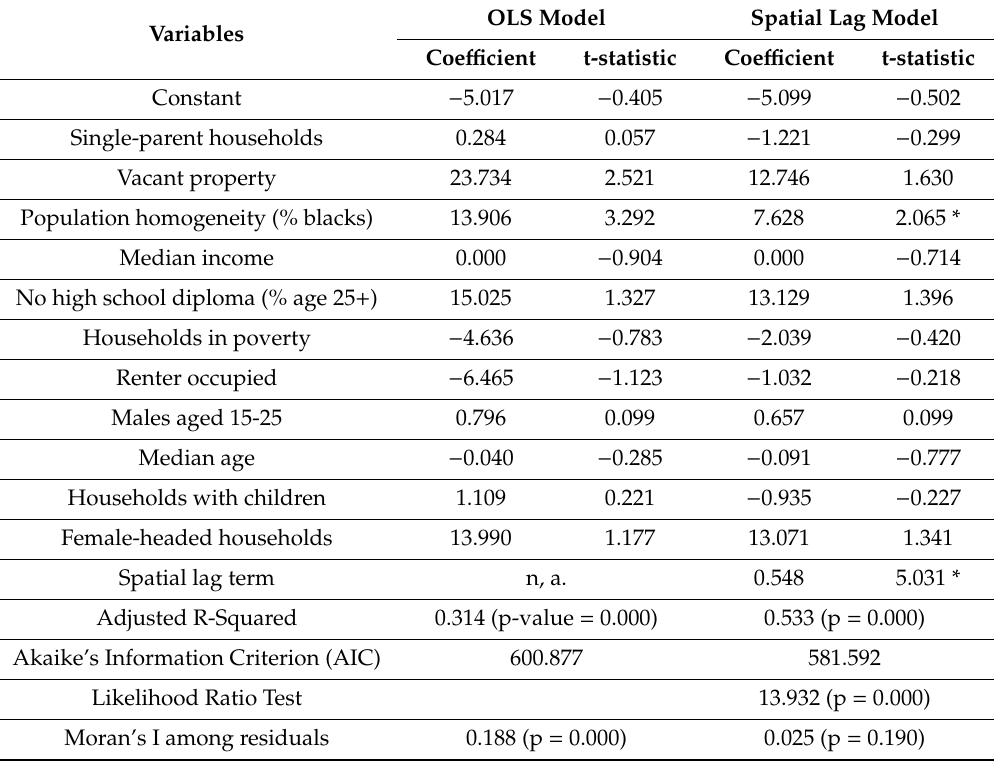
Table 5. Results of OLS and spatial regression models for all GDT events (n = 82). OLS Model Spatial Lag Model Variables Coe ffi cient t-statistic Constant Single-parent